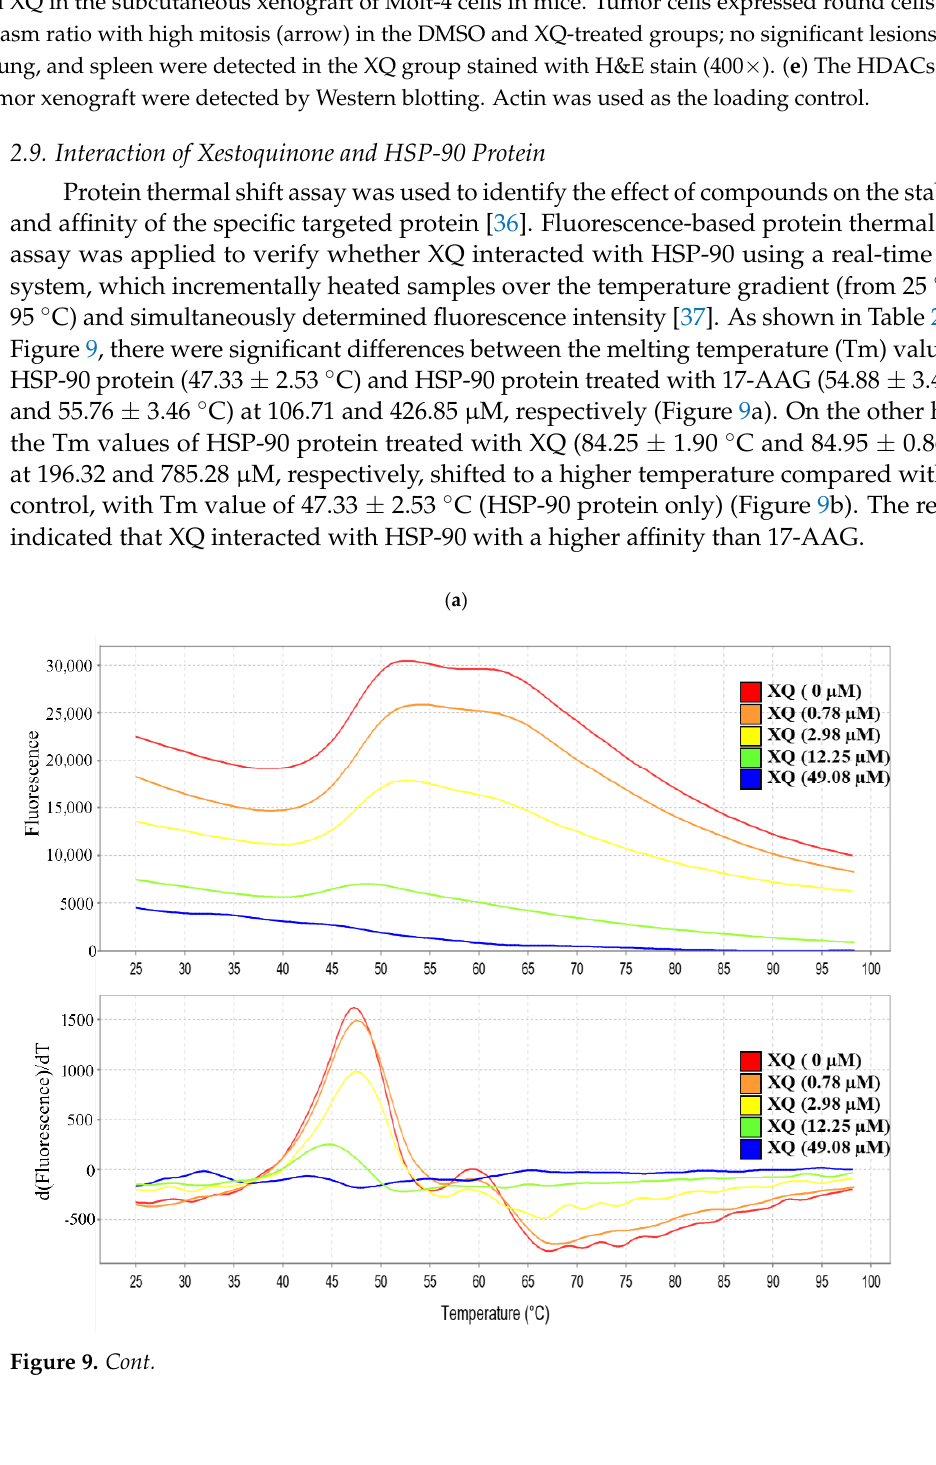
Figure 9. Melting profile of HSP-90. Melting profile of HSP-90 (1 μg) with different doses of ( a ) xestoquinone (XQ) and ( b ) 17-AAG. The upper figures show the thermal denaturation profiles of HSP-90 proteins with XQ or 17-AAG, respectively. The lower figures show the profiles of the deriv -